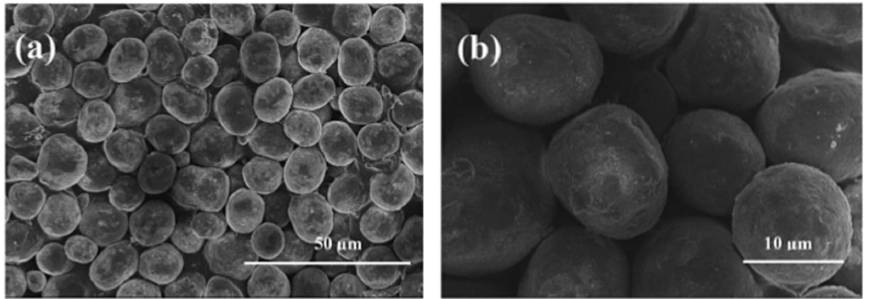
Figure 3. SEM images of spherical Ni 0.5 Mn 0.5 CO 3 carbonate by the Coprecipitation route at ( a ) 50 µm